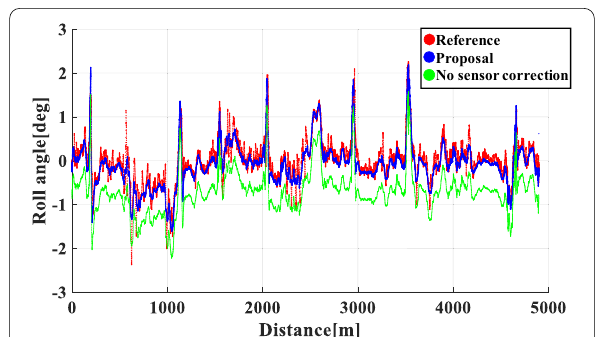
Fig. 10 Estimated roll angle (Urban street)